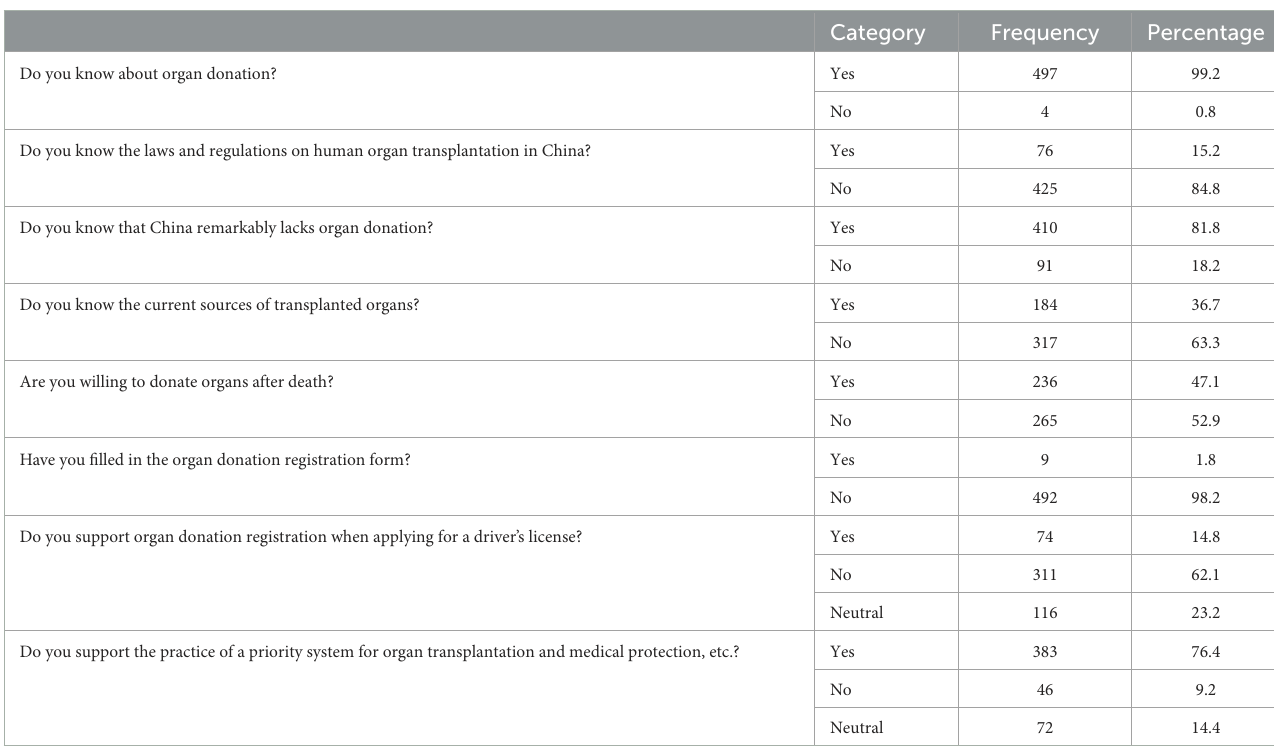
TABLE 2 Respondents’ awareness of organ